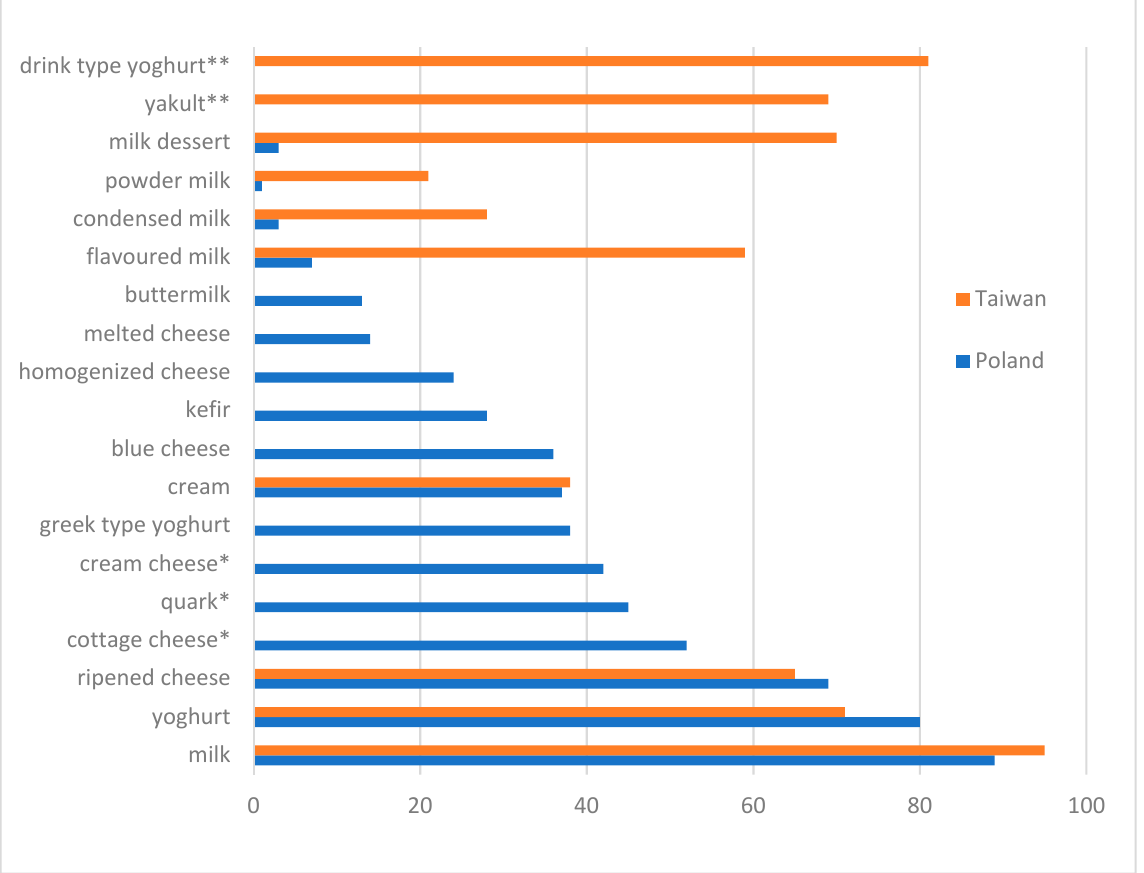
Figure 1. Most commonly consumed dairy products (%) (* products typical for Poland, ** products typical for Taiwan).